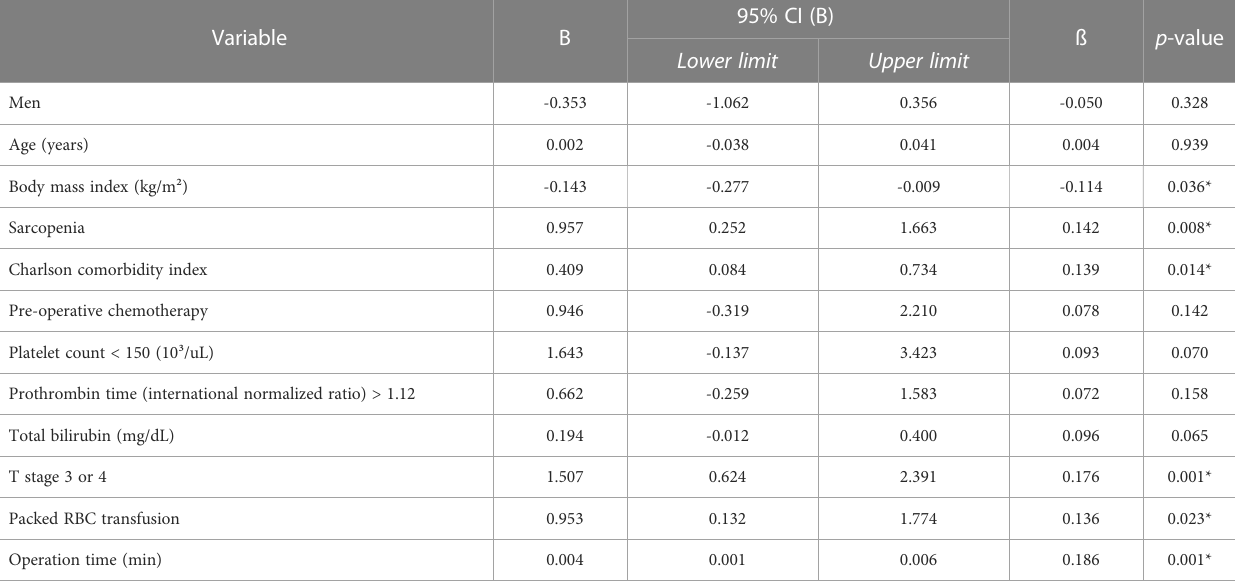
TABLE 4 Multivariate linear regression analysis for risk factors of postoperative length of ICU stay (days).